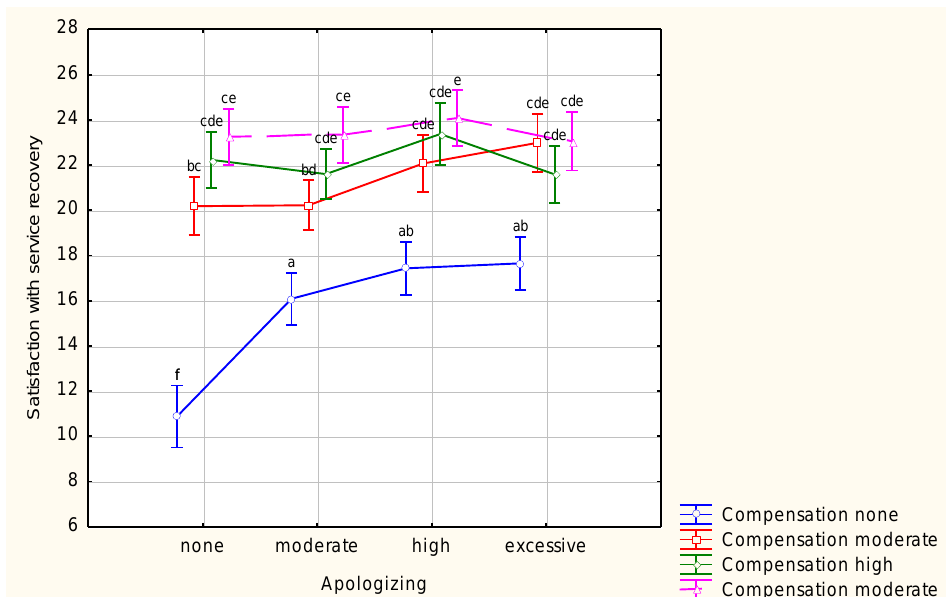
Figure 1: A LS means plot of satisfaction with service recovery at different levels of compensation and apologising: Study 1